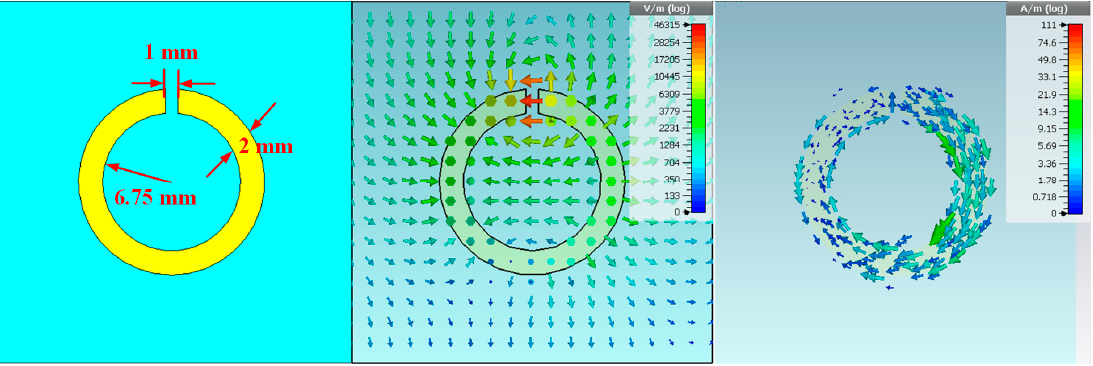
Figure 1. Structure of the device used in the measurements ( left ), E filed orientations at resonance ( middle ) and surface current densities at resonance ( right